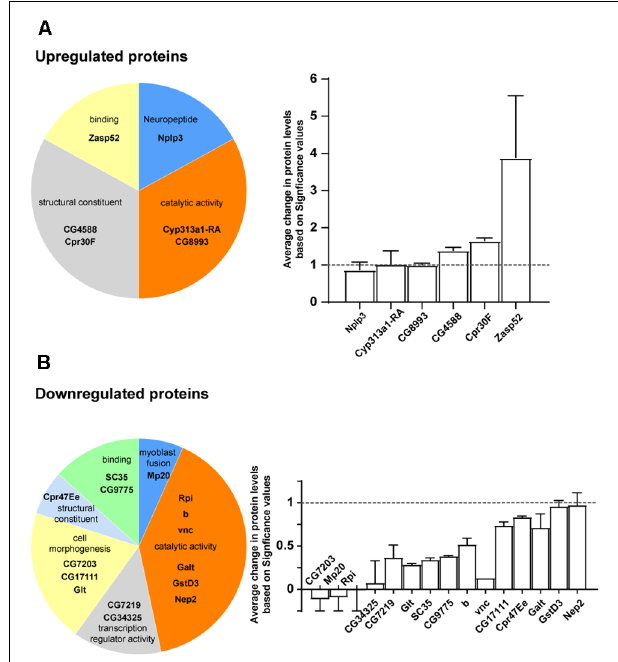
FIGURE 6 | Mass spectrum analysis of CG5003 downstream effector proteins. (A,B) Representative proteins identified in mass spectrum analysis comparing samples from control and elav > CG5003-RNAi animals. The significance values are calculated based on protocols described previously